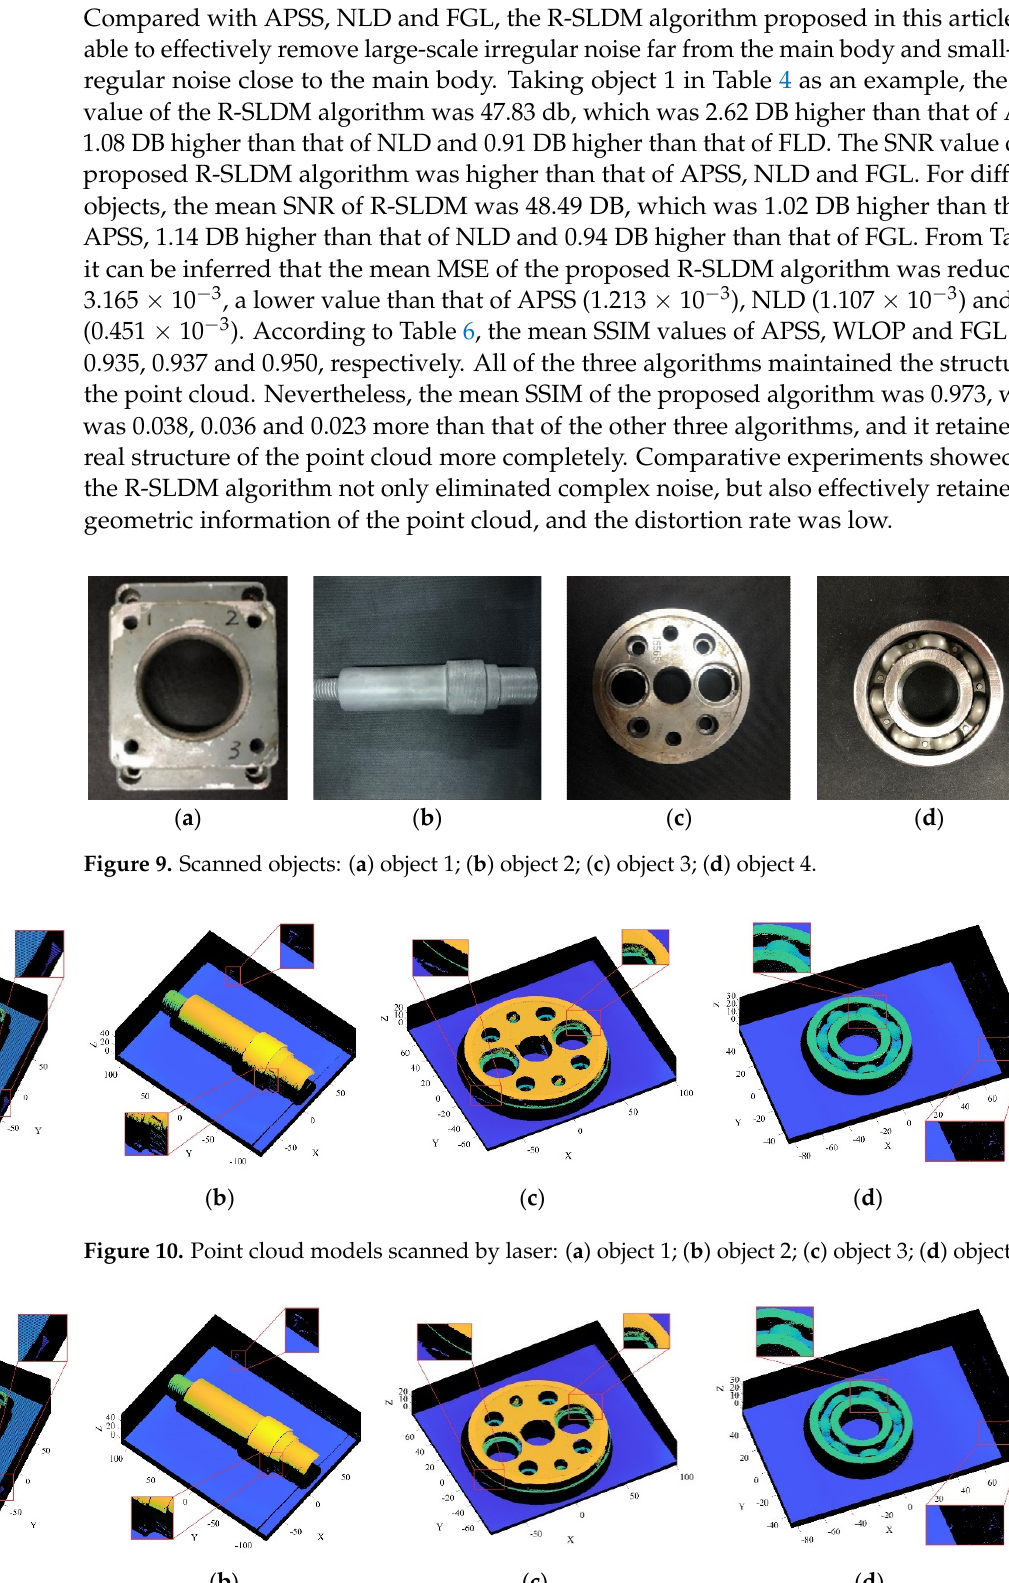
Figure 11. Denoising results for APSS algorithm: ( a ) object 1; ( b ) object 2; ( c ) object 3; ( d ) object 4.